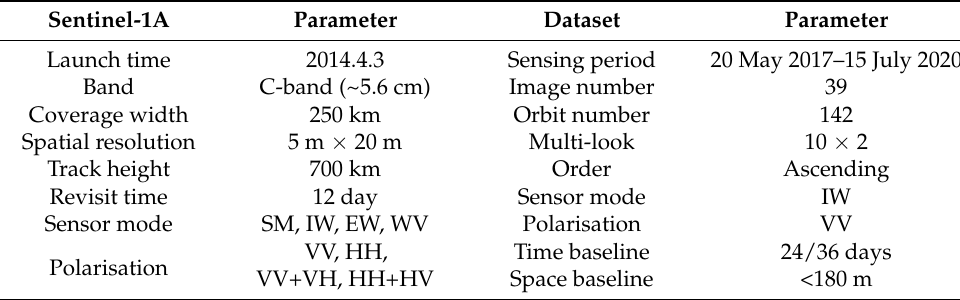
Table 1. Parameters of Sentinel-1A sensor and datasets used in this study. Sentinel-1A Parameter Dataset